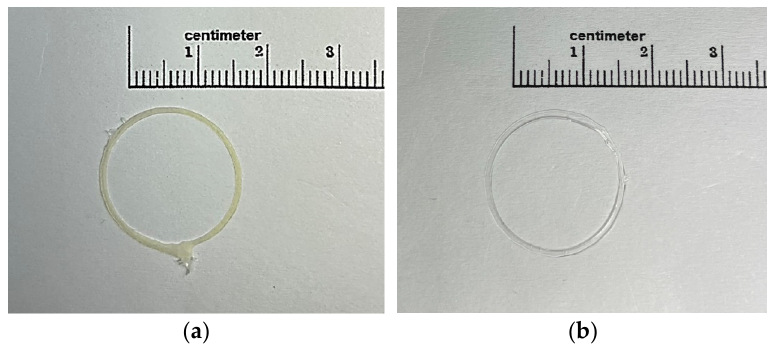
Figure 3. Printed filament diameter of 3D ‐ MTZ ( a ) and blank ( b ).